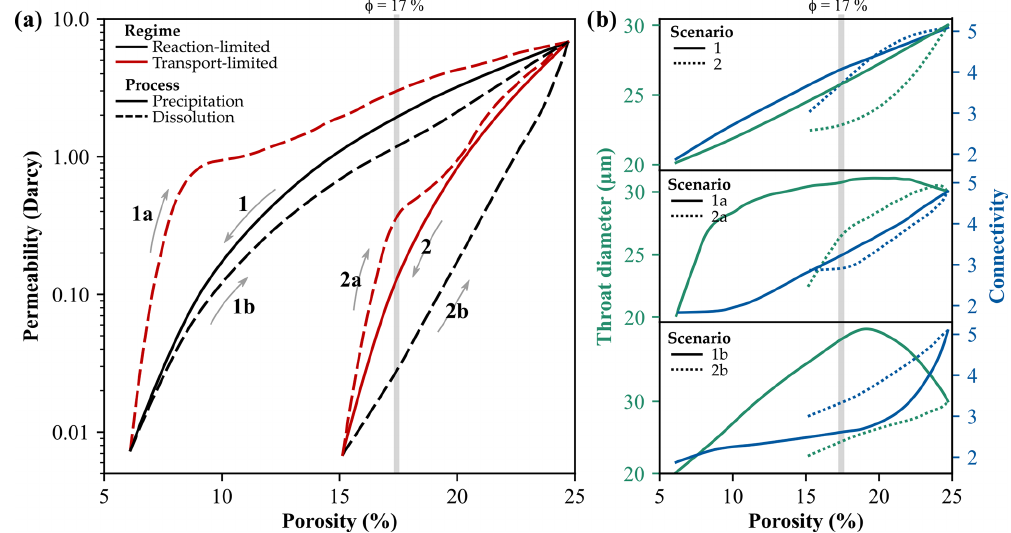
Figure 5. (a) Porosity-permeability curves for the six investigated reaction paths of the simulated precipitation-dissolution cycle. (b) Char- acteristic evolution of the median throat diameter (green) and mean connectivity (blue) depend on the geochemical process and dominating reaction regime. At a porosity of 17%, permeability varies by more than two orders of